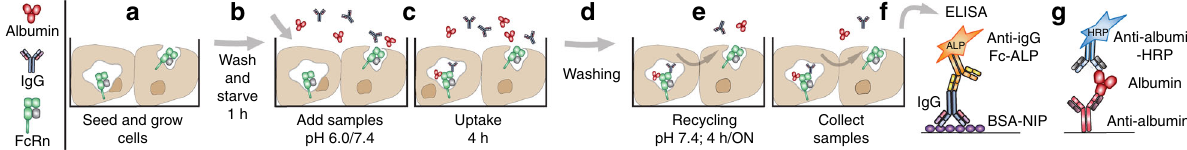
Fig. 1 The HERA protocol. a HMEC1-hFcRn cells are seeded and grown until con fl uent. b Cells are washed and starved for 1 h using HBSS (pH 7.4). c The protein of interest is diluted in HBSS (pH 7.4 or 6.0) and added to cells and incubated for 4 h. d Medium is removed and cells are extensively washed with ice cold HBSS (pH 7.4) before the cells are lysed or e pre-heated HBSS (for 4 h incubation) or growth medium (for overnight incubation (ON)) is added, incubated and samples collected. f Cells are extensively washed with ice cold HBSS (pH 7.4) and lysed. g The collected samples are analysed in ELISAs speci fi c for IgG or